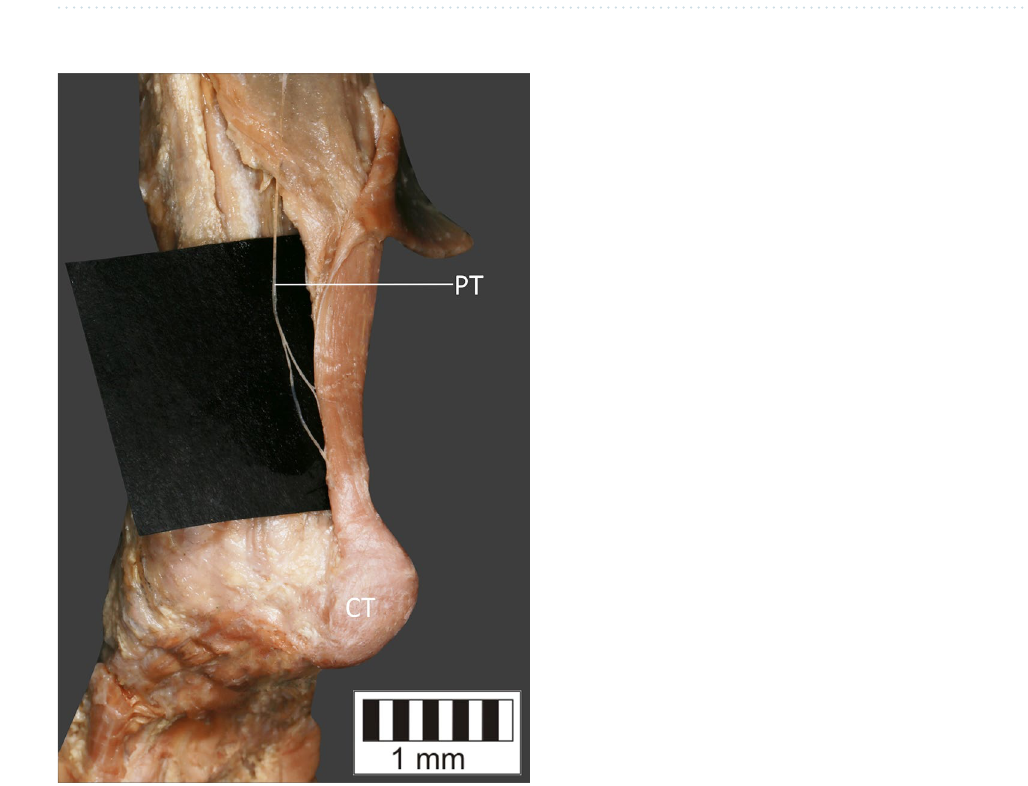
Figure 9. Type VII of plantaris tendon. CT calcaneal tuberostity, AT Achilles tendon, PT plantaris tendon.